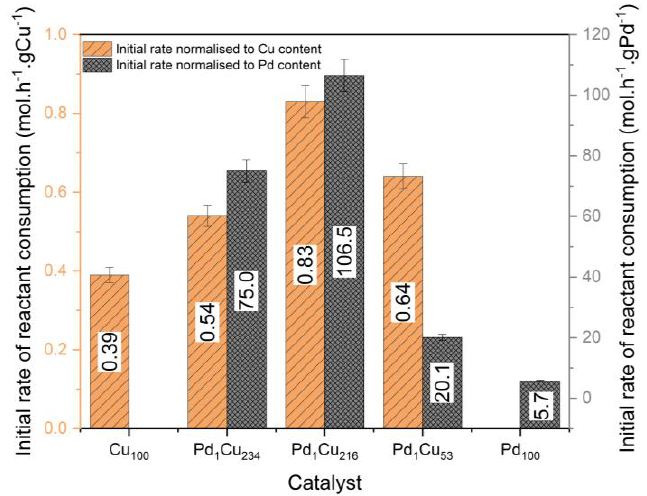
Figure 5. Initial rate of crotonaldehyde consumption normalised to Cu and Pd content for the hydrogenation of crotonaldehyde. The initial rate was determined after the induction period for the Cu-based catalysts. Reaction conditions: 7 h, 50 °C, 1.5 bar H 2 , 600 RPM, and 10 mg of catalyst.